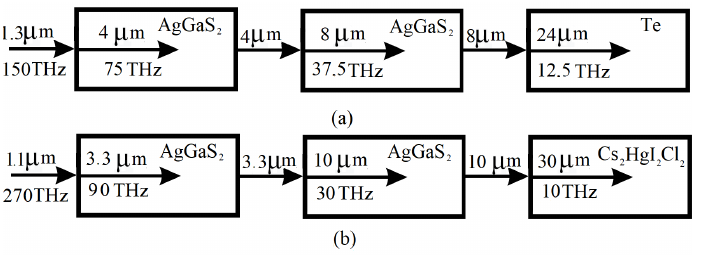
Figure 7. Two possible schemes of the frequency down-conversion to the THz range of the